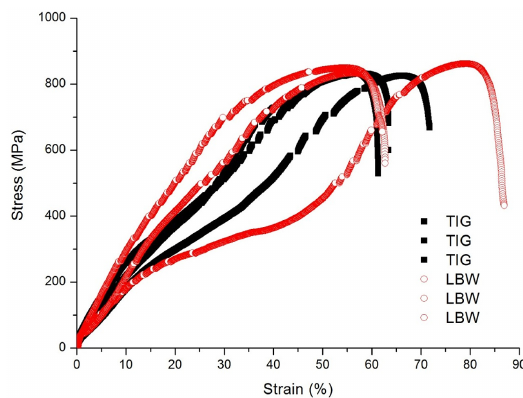
Figure 5. Tensile strain-stress curves for the TIG and laser welded samples.